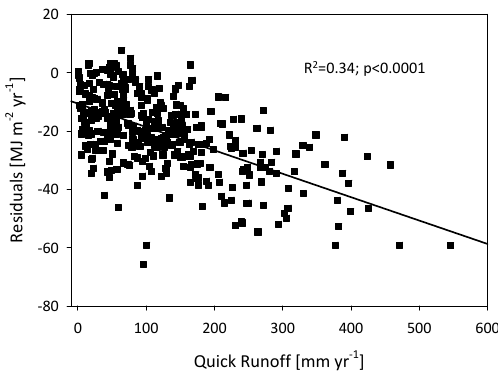
) relative to 357 MOPEX-MODIS ), and (c) biological chemical 359 PPT-MODEL ) and modeled primary 360 BIO-MODIS